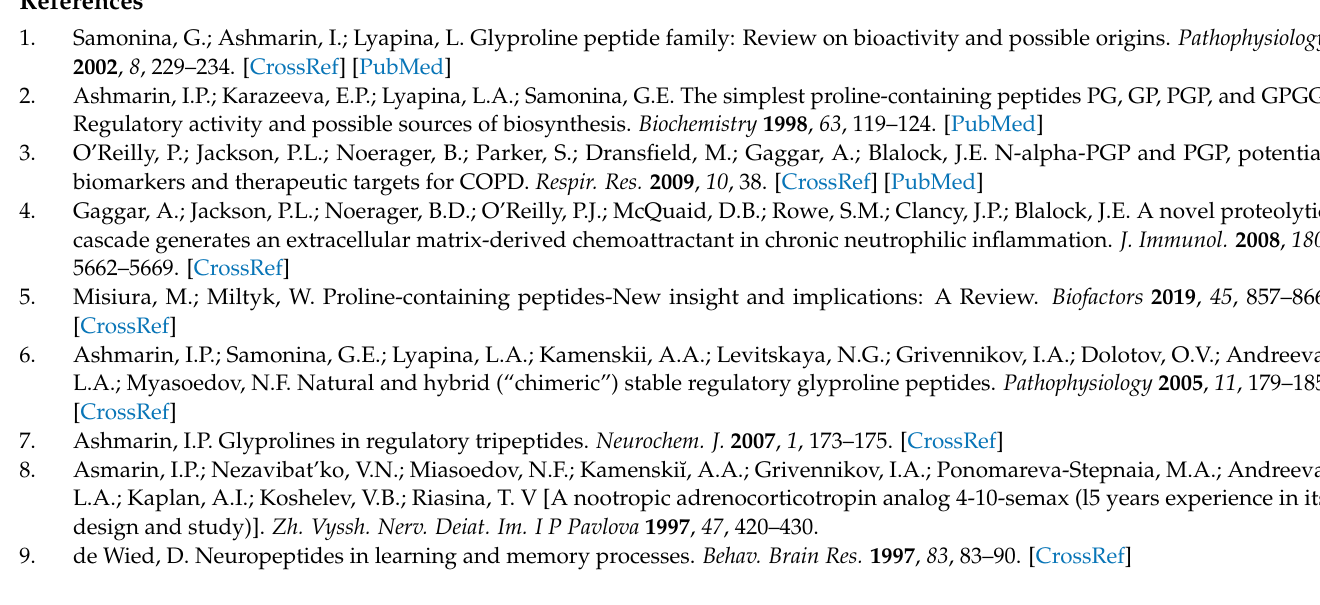
(PCA) of the normalized transcription counts within the three experimental groups (SH, IR, and IS). Figure S2: Selection of genes to study PGP-containing peptides’ action under ischemia–reperfusion (IR) conditions based on our previous results. Table S1: The characterization of the primers for real-time RT-PCR. Table S2: Analysis of the functional annotations of DEGs in IS versus IR using GSEA. Table S3: Analysis of the functional annotations of DEGs in IS versus IR using